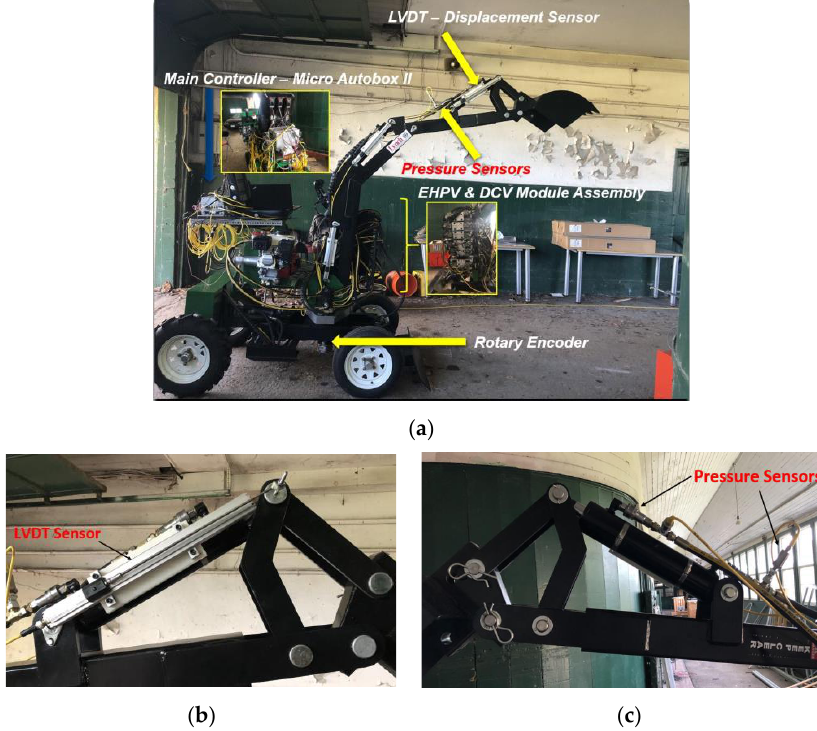
Figure 11. Test Platform Setup: ( a ) Modified mini excavator; ( b ) LVDT stroke sensor; ( c ) Pressure sensor.